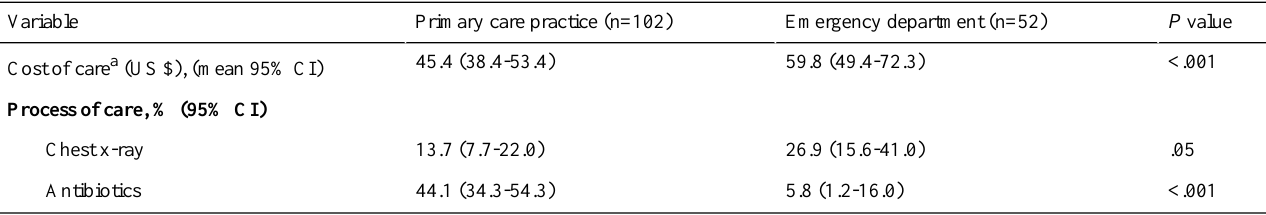
Table 1. Mean cost of care and percentage of use of nonrecommended care applied to upper respiratory tract infection in a primary care practice and an emergency